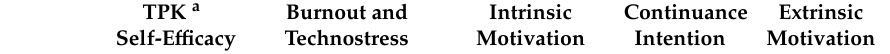
Table 1. Factor loadings as results of Exploratory Factor Analyses (EFA) ( n 1 =